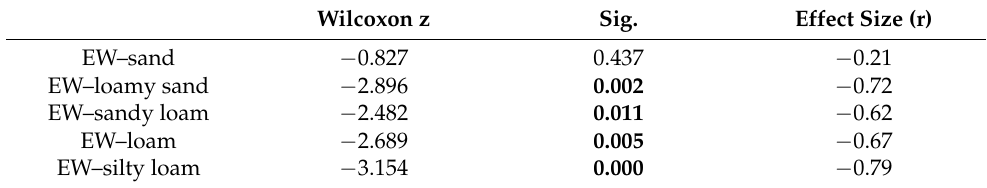
Table 4. Comparison of the evaporated water (EW) and soil texture categories (Wilcoxon test; p < 0.05 was highlighted in